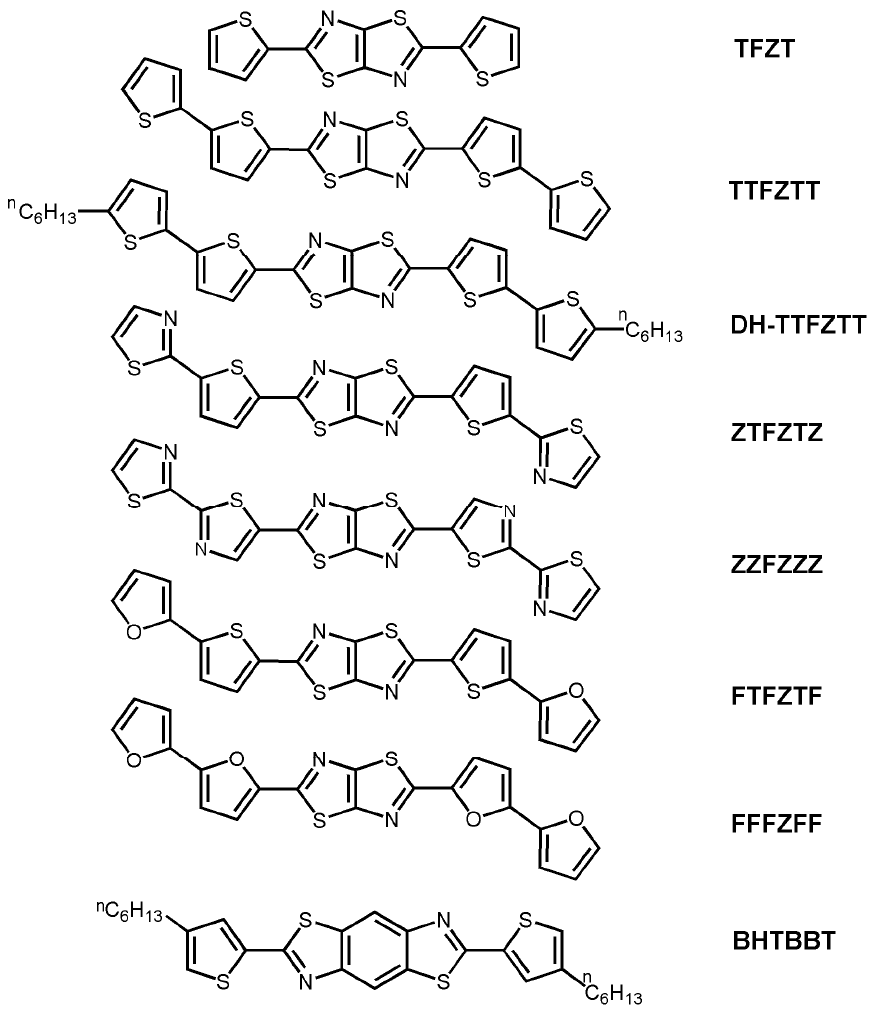
Figure 3. Chemical structures of thiazolothiazole oligomers and benzobisthiazole BHTBBT